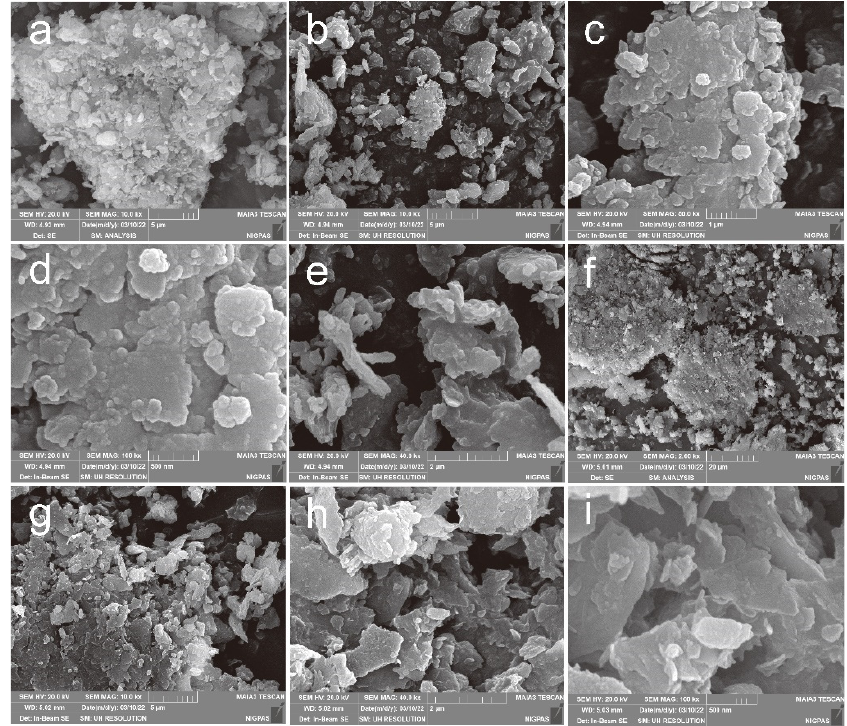
Figure 6. SEM images of clay minerals of 1ayer 180–190 cm of GC04 ( a – e ) and layer 30–40 cm of GC1601 ( f – i ). ( a , b ) large scale microphotographs of clay minerals; ( c – e ) montmorillonite illite layer; ( f , g ) large scale microphotographs of clay minerals; ( h , i ) schistose illite with good crystalline mor- phology.